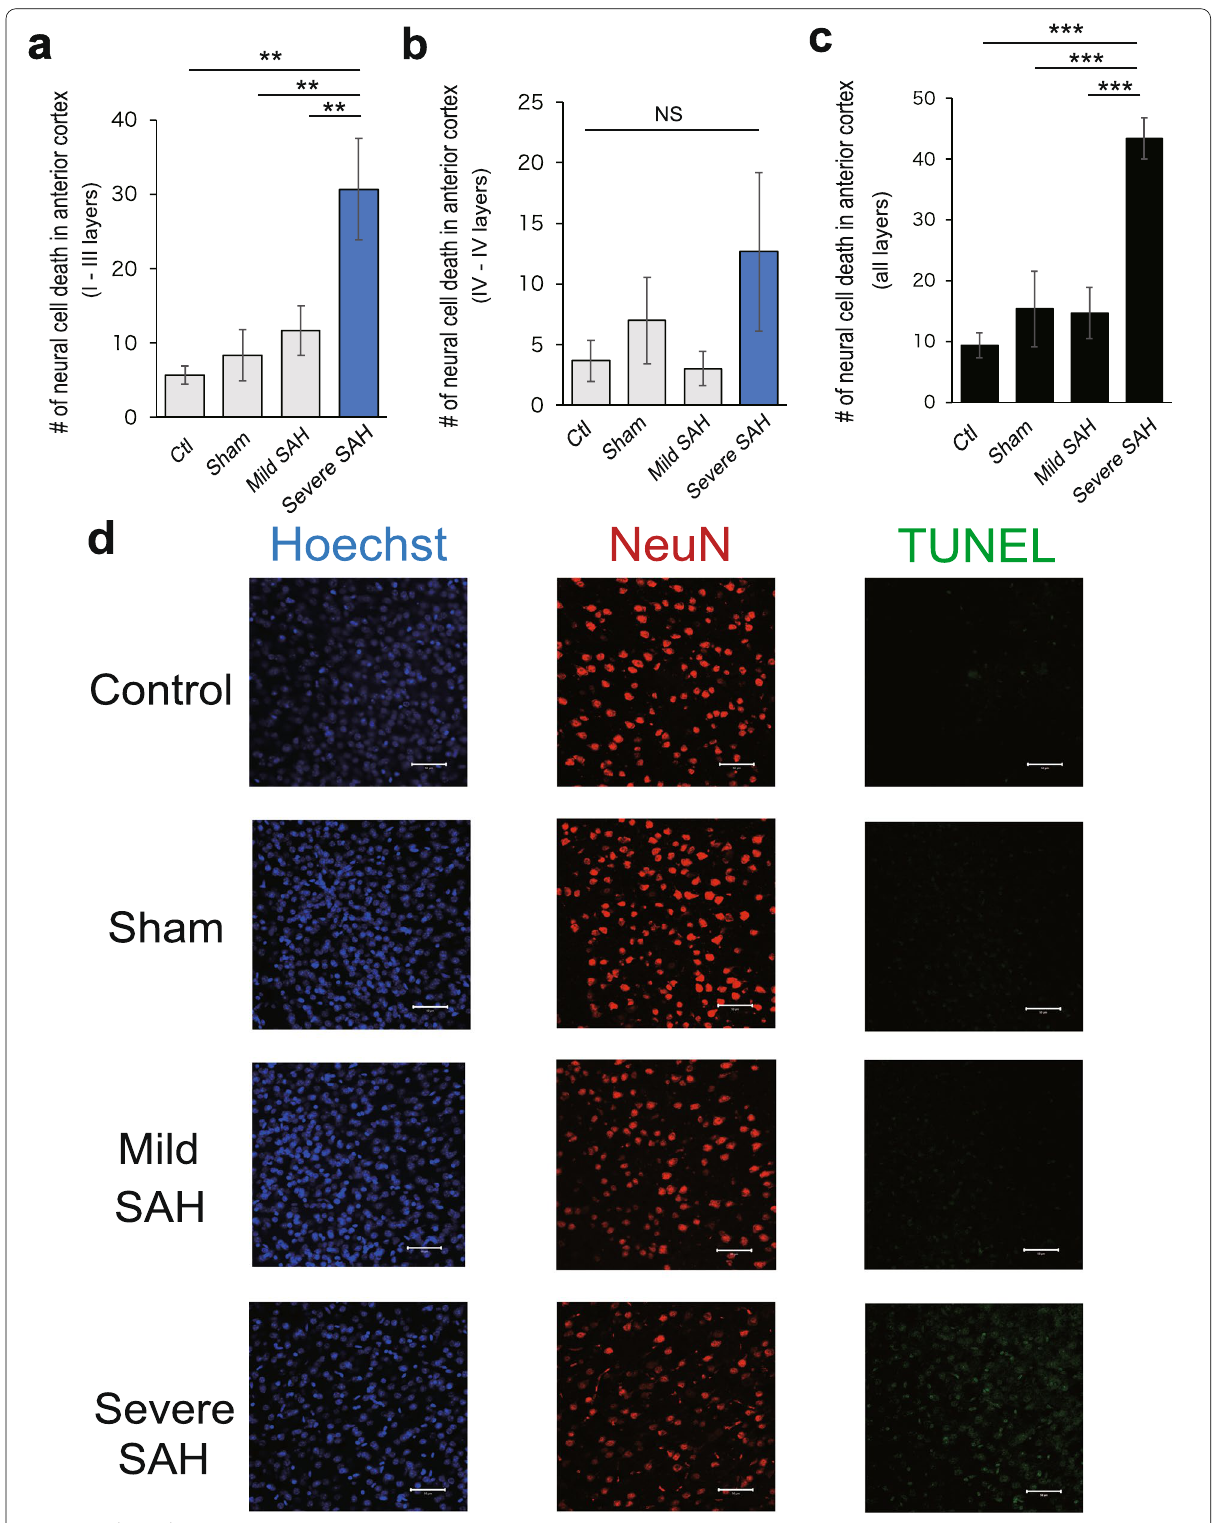
Fig. 8 (See legend on previous